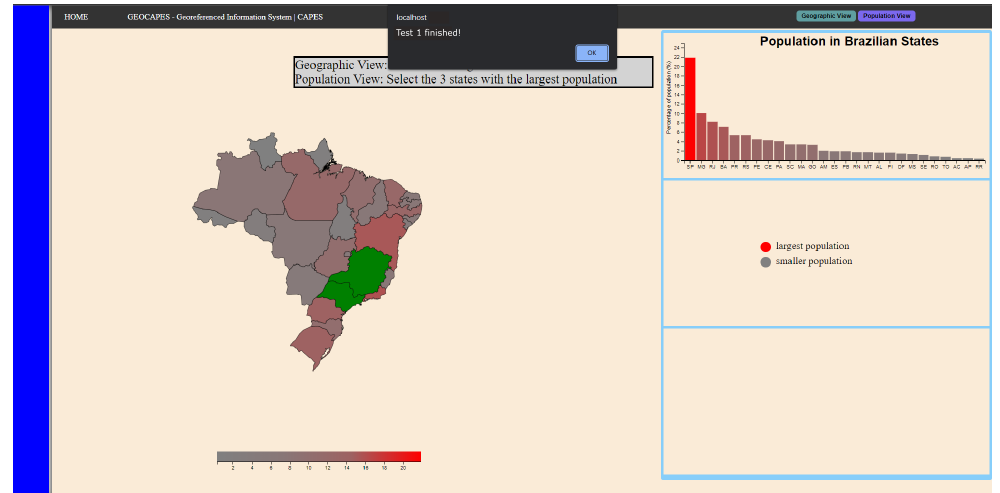
Figure 8. Final state of the second step of the task in scenario